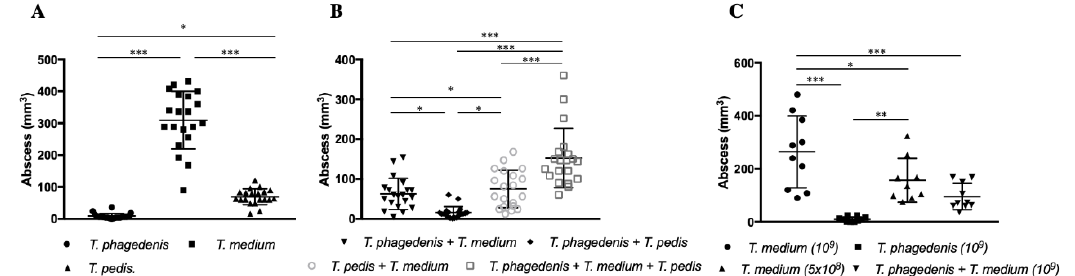
Figure 2. Skin abscess size after subcutaneous inoculation with single or multiple Treponema spp. ( A ) Lesion size (mm 3 ) in mice infected with single Treponema spp. ( B ) Lesion size in mice infected with Treponema spp. combinations. ( C ) Skin lesion size in Experiment 2 carried out with single and Treponema spp. pair combination. Graphs representing mean and the error bars indicating the standard deviations are presented. * p < 0.05, ** p < 0.01, *** p < 0.001 .